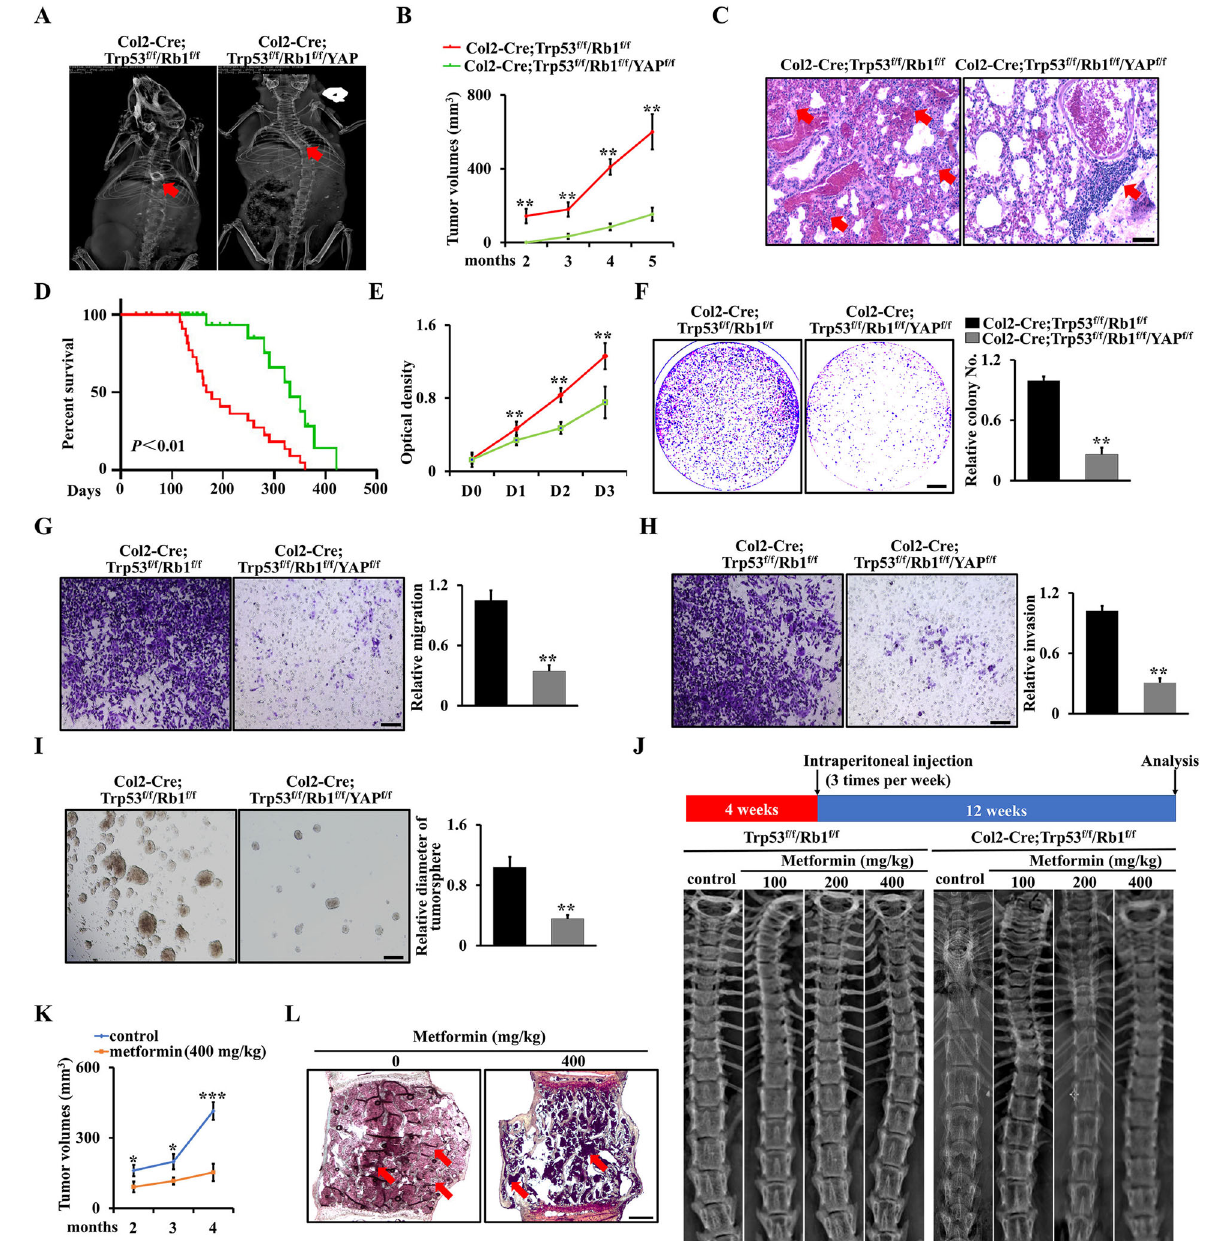
Fig. 6 Inhibition of YAP signaling delays chondrosarcoma progression in Col2-Cre;Trp53 f/f /Rb1 f/f mice. A Representative X-ray images of Col2-Cre;Trp53 f/f /Rb1 f/f and Col2-Cre;Trp53 f/f /Rb1 f/f /YAP f/f mice at 6 months. The red arrows direct to the destruction in the spine. B Tumor volume analysis as indicated. N = 5. C Representative H&E staining images of chondrosarcoma lung metastasis as indicated. N = 3. Scale bar, 100 μ m. D Kaplan – Meier survival analysis indicating overall survival of Col2-Cre;Trp53 f/f /Rb1 f/f mice and controls as indicated. N = 30. E Cell proliferation rate of chondrosarcoma cells from Col2-Cre;Trp53 f/f /Rb1 f/f and Col2-Cre;Trp53 f/f /Rb1 f/f /YAP f/f mice as shown by WST-1 assay after D0, D1, D2, and D3. F – I Representative images and quantitative analysis of soft agar ( F ), migration ( G ), invasion ( H ), and tumorsphere ( I ) using primary chondrosarcoma cells from Col2-Cre;Trp53 f/f /Rb1 f/f and Col2-Cre;Trp53 f/f /Rb1 f/f /YAP f/f mice as indicated. N = 3. J Representative X-ray images of spines after treatment with metformin (100, 200, and 400 mg/kg) or PBS (control) three times per week for 3 months as indicated. N = 5. K Tumor volume analysis after treatment with 400 mg/kg metformin or PBS (control) three times per week for 3 months as indicated. N = 5. L Representative Safranin O/Fast Green staining images of spinal chondrosarcoma from Col2-Cre;Trp53 f/f /Rb1 f/f mice after treatment with metformin (0 and 400 mg/kg) three times per week for 3 months as indicated. N = 3. The red arrows direct to chondrosarcoma in the spine. Error bars were the means ± SEM from three independent experiments. * P < 0.05, ** P < 0.01, *** P < 0.001. metastasis in Col2-Cre;Trp53 f/f /Rb1 f/f mice and the Kaplan – Meier chondrocytes promoted YAP expression and nuclear translocation and elevated the YAP/TEAD1 transcriptional activity. On the contrary, survival curves plotted for the mice showed a signi fi cantly longer knockdown of YAP showed a reduced ability of chondrosarcoma cell mean survival rate in the triple cKO mice compared with the double migration and invasion and tumor formation. In vivo, we found loss- cKO mice. All these fi ndings suggested that Hippo-YAP signaling may of-function of YAP delayed chondrosarcoma progression and lung be a potent driver of the onset and progression of chondrosarcoma. Cell Death and Disease (2022)